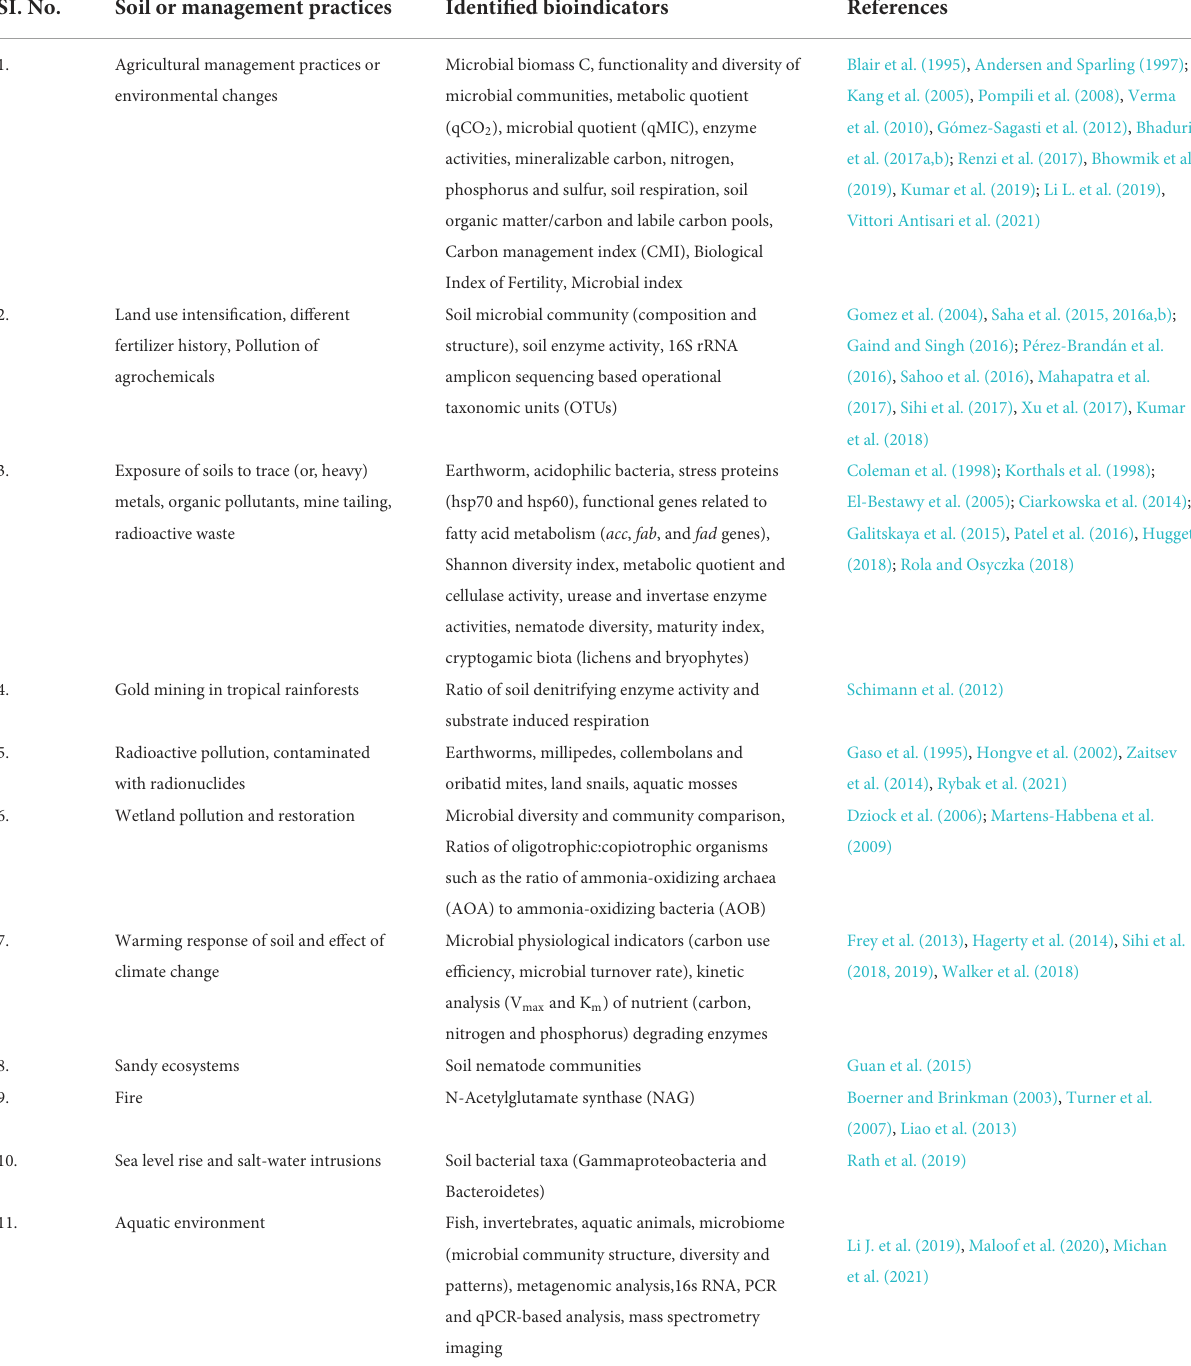
TABLE 1 Important bio-indicators identified for different soil ecosystems. SI.